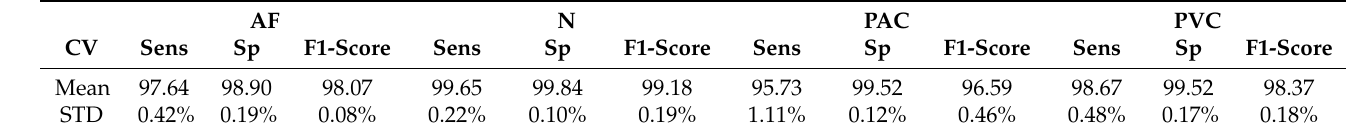
Table 11. Evaluation of the accuracy through Sens, Sp, and F1-score with cross-validation (5-fold) in the second stage. N PVC